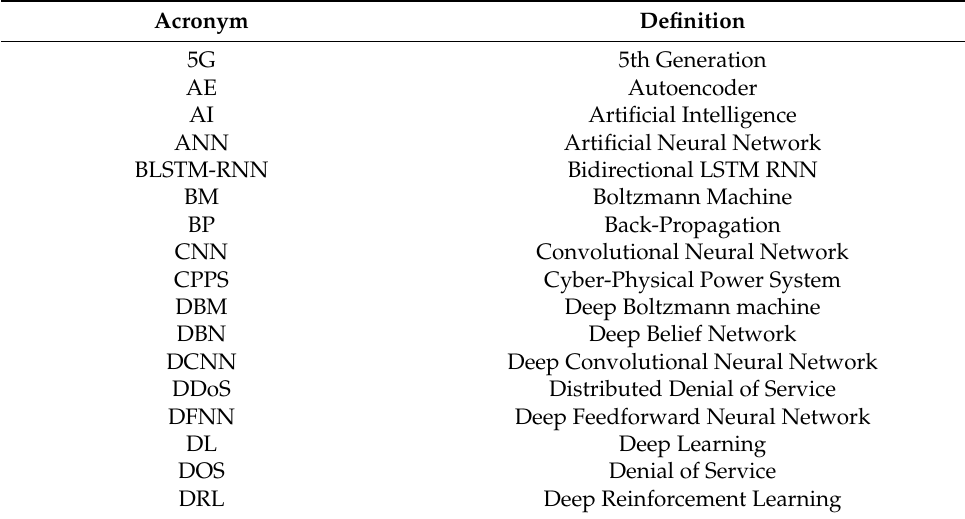
Table A1. List of acronyms used in this review along with their